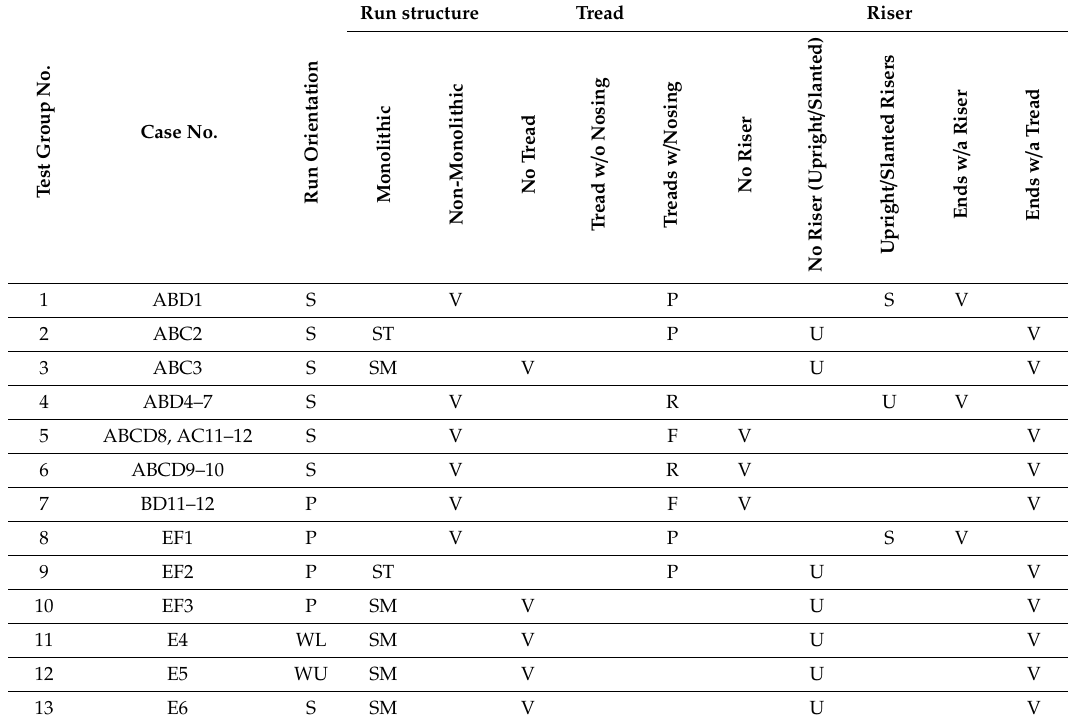
Figure 16. The test cases chosen to verify the proposed algorithm. Table 2. Combinations of run orientations and modeling parameters among the test cases.